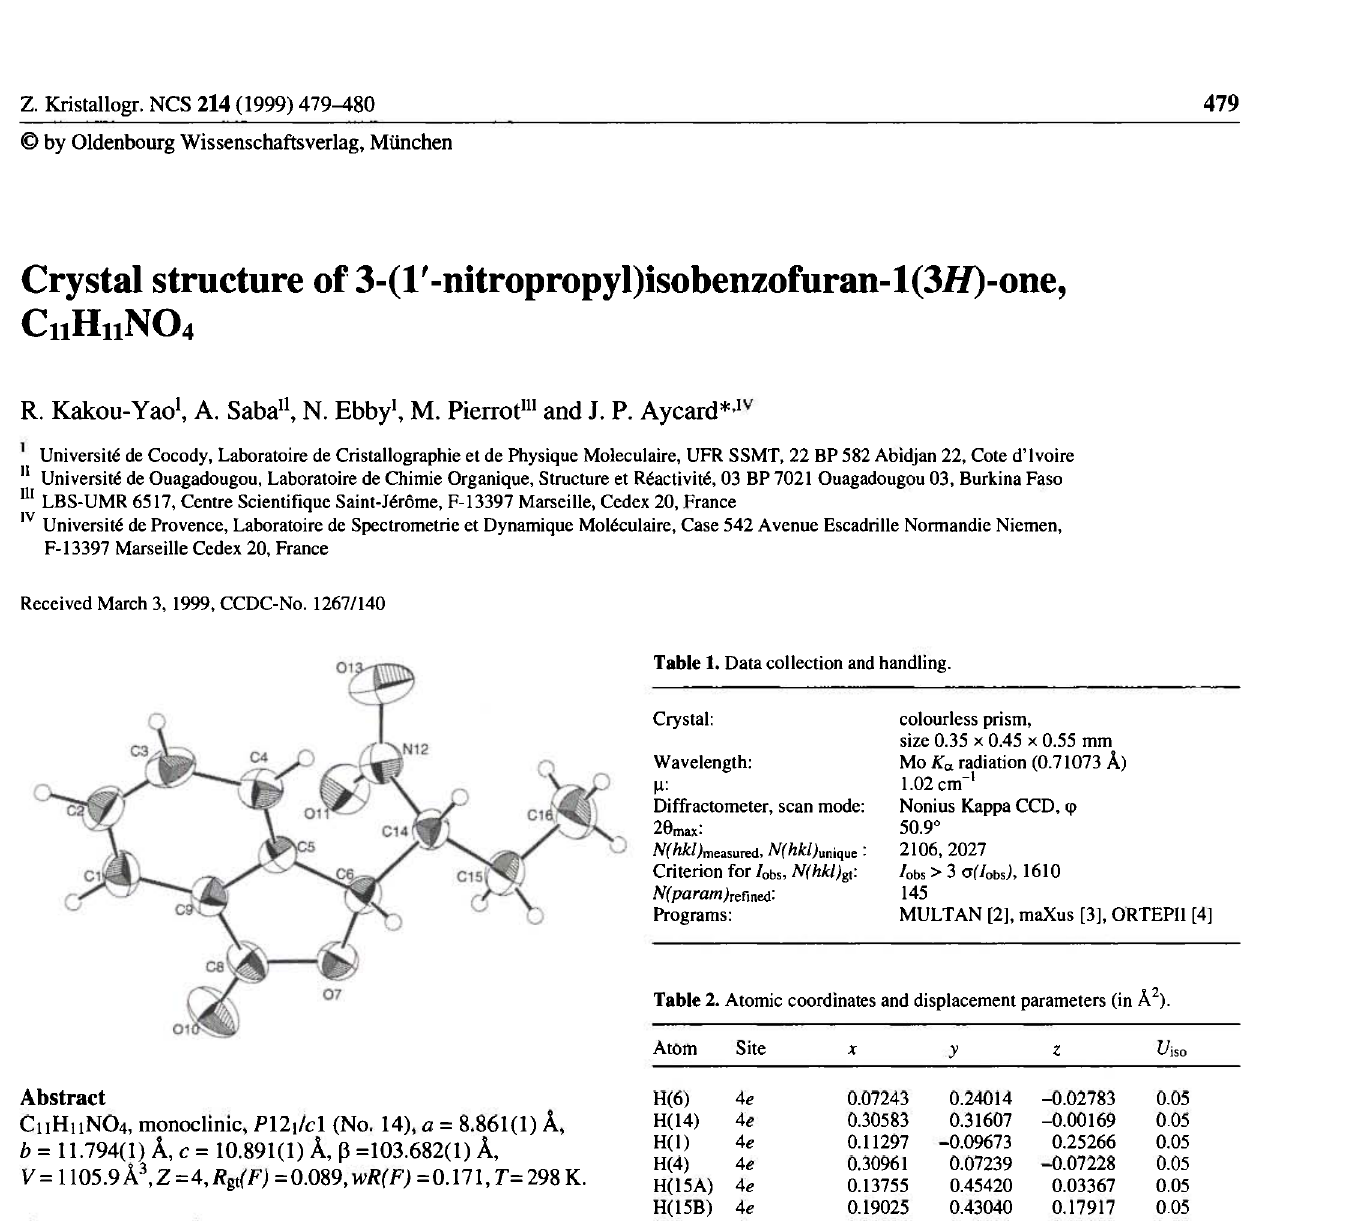
Table 2. Atomic coordinates and displacement parameters (in Ä 2